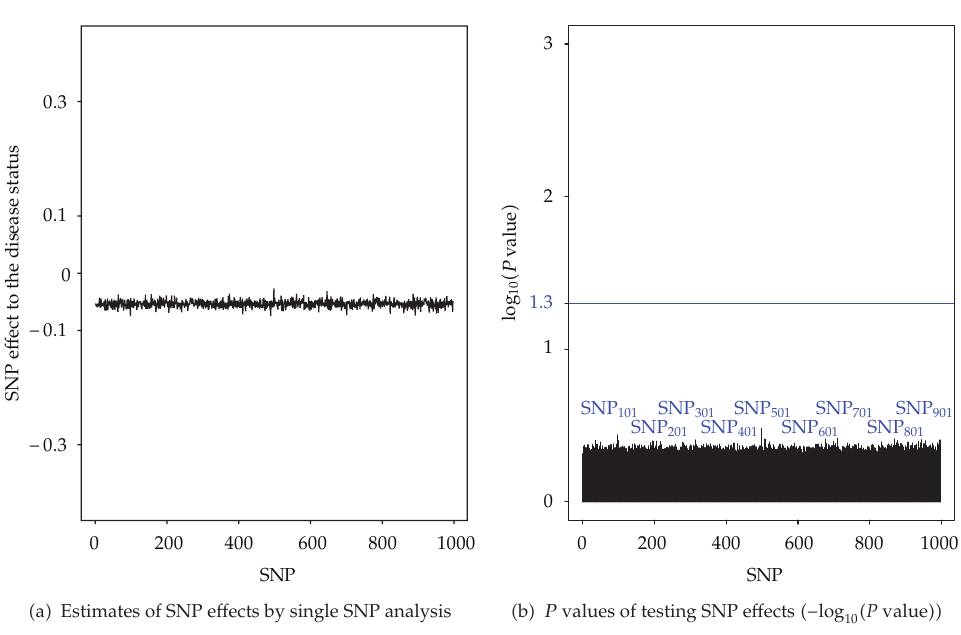
Figure 2: Analysis of the simulated data sets with single SNP